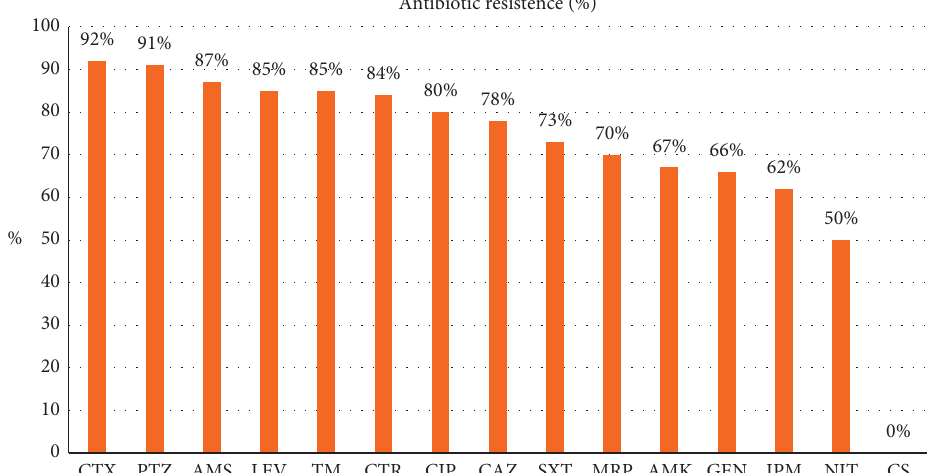
Figure 1: The prevalence (%) of resistance to antibiotics in K. pneumoniae isolates. CS, colistin; NIT, nitrofurantoin; IPM, imipenem; GEN, gentamicin; AMK, amikacin; MRP, meropenem; SXT, trimethoprim-sulfamethoxazole; CAZ, ceftazidime; CIP, ciprofloxacin; CTR, ceftriaxone; TM, tobramycin; LEV, levofloxacin; AMS, ampicillin-sulbactam; PTZ, piperacillin-tazobactam; CTX, cefotaxime. Table 1: Prevalence of antibiotic resistance in K. pneumoniae isolated from different clinical samples.